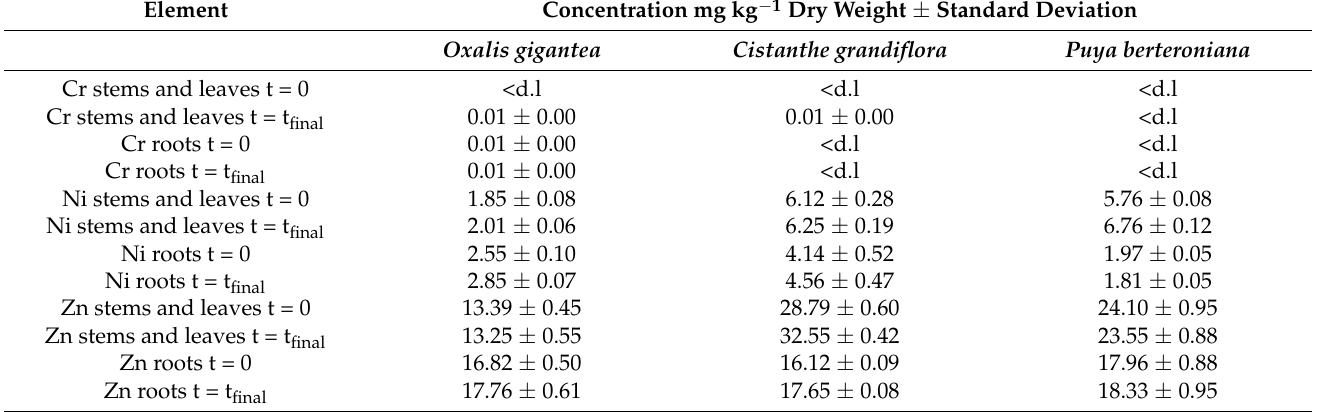
Table 3. The initial and final concentrations of Cr, Ni, and Zn in the control samples ± standard deviation.